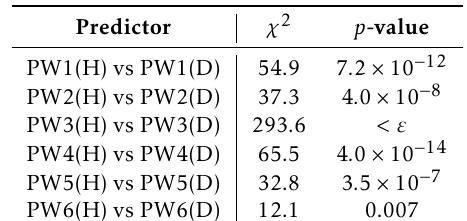
Table 6. Results of the Stuart-Maxwell χ 2 tests on participants’ perception of human-generated and machine-generated password ratings for different passwords (“hidden” to